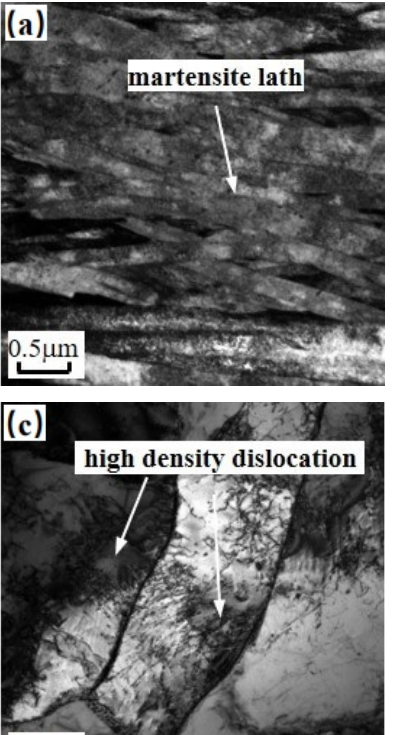
Table 4. Hardness of BF and GB of the welded joint.